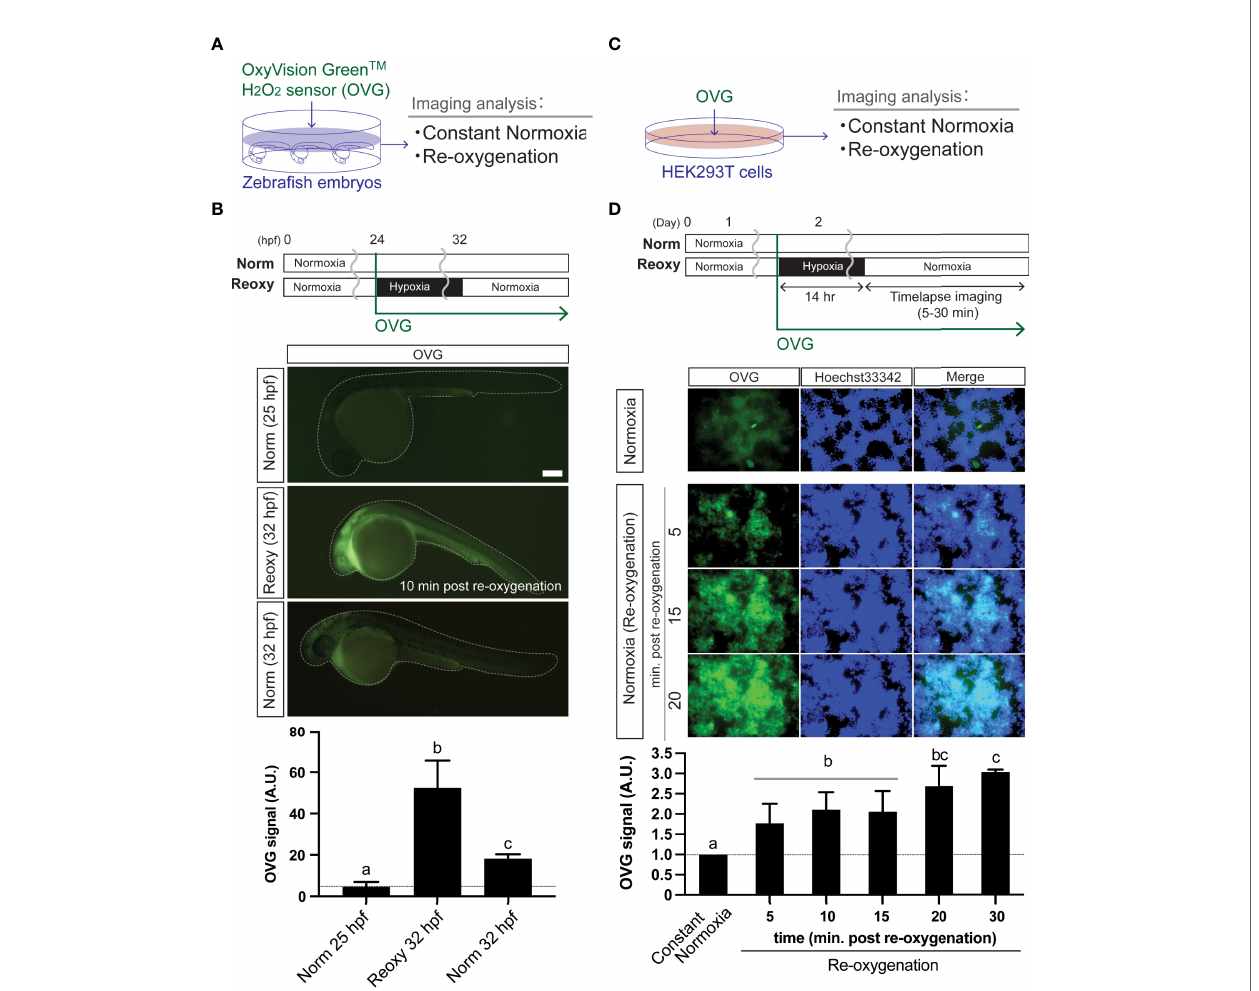
FIGURE 2 | Re-oxygenation increases H 2 O 2 generation in the zebra fi sh embryo and mammalian cells. (A) Experiment summary. The zebra fi sh embryos exposed with a speci fi c H 2 O 2 sensor probe (OxyVision Green ™ : OVG) were placed in distinct environments (constant normoxia: Norm and re-oxygenation: Reoxy) and subjected to imaging analysis. (B) The 24 hpf zebra fi sh embryos were exposed to hypoxia with 10 m M of OVG for 8 hr. Then, the fl uorescence intensity at around 10 minutes after re- oxygenation was measured. The stage-matched (25 hpf Norm) and the chronological age-matched (32 hpf Norm) embryos were also tested for comparison. Bar, 100 m m. The OVG signal was calculated relative to the signal intensity of the 25 hpf Norm embryos. Data are mean ± SE of 5 independent experiments. The different letter denotes statistical signi fi cance at P<0.05 . (C) Experiment summary. The human embryonic kidney cells (HEK293T cells) exposed with OVG were placed in Norm or Reoxy condition and subjected to imaging analysis. (D) The cells were exposed to 14 hr-long hypoxia with 5 m M of OVG. The OVG signal was calculated relative to the signal intensity of the Norm cells. Data are mean ± SE of 4-5 independent experiments. Values marked with different letters (a, b, c) are signi fi cantly different from each other ( P<0.05 ), but values marked with common letters (b and bc; bc and c) are not signi fi cantly different from each other ( P>0.05